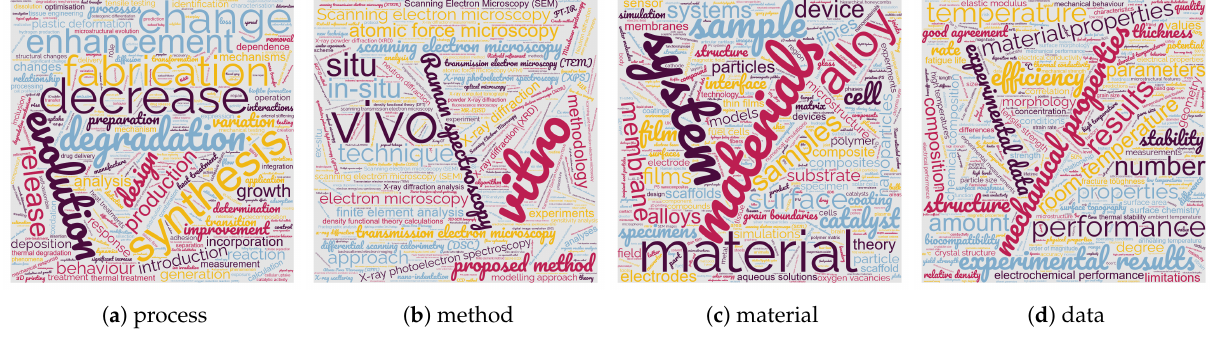
Figure 8. Material Science domain word